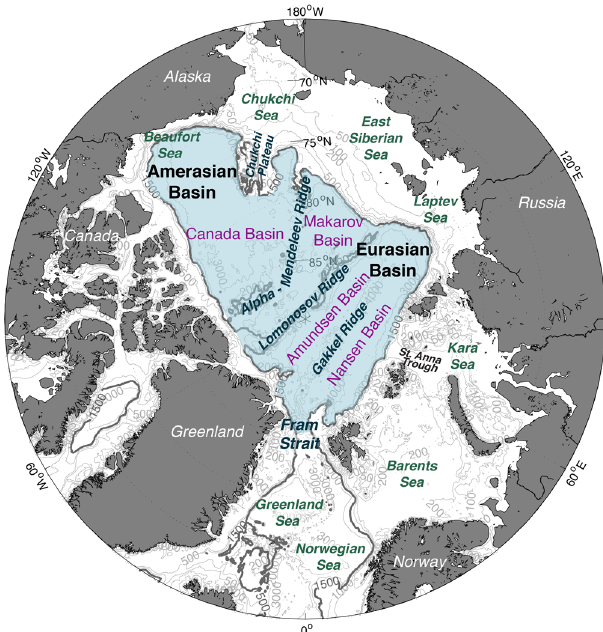
Fig. 1 Map of the Arctic Ocean. Blue shading denotes the region considered to be the central basin for the purposes of this study, generally following the 1500 m isobath (bold